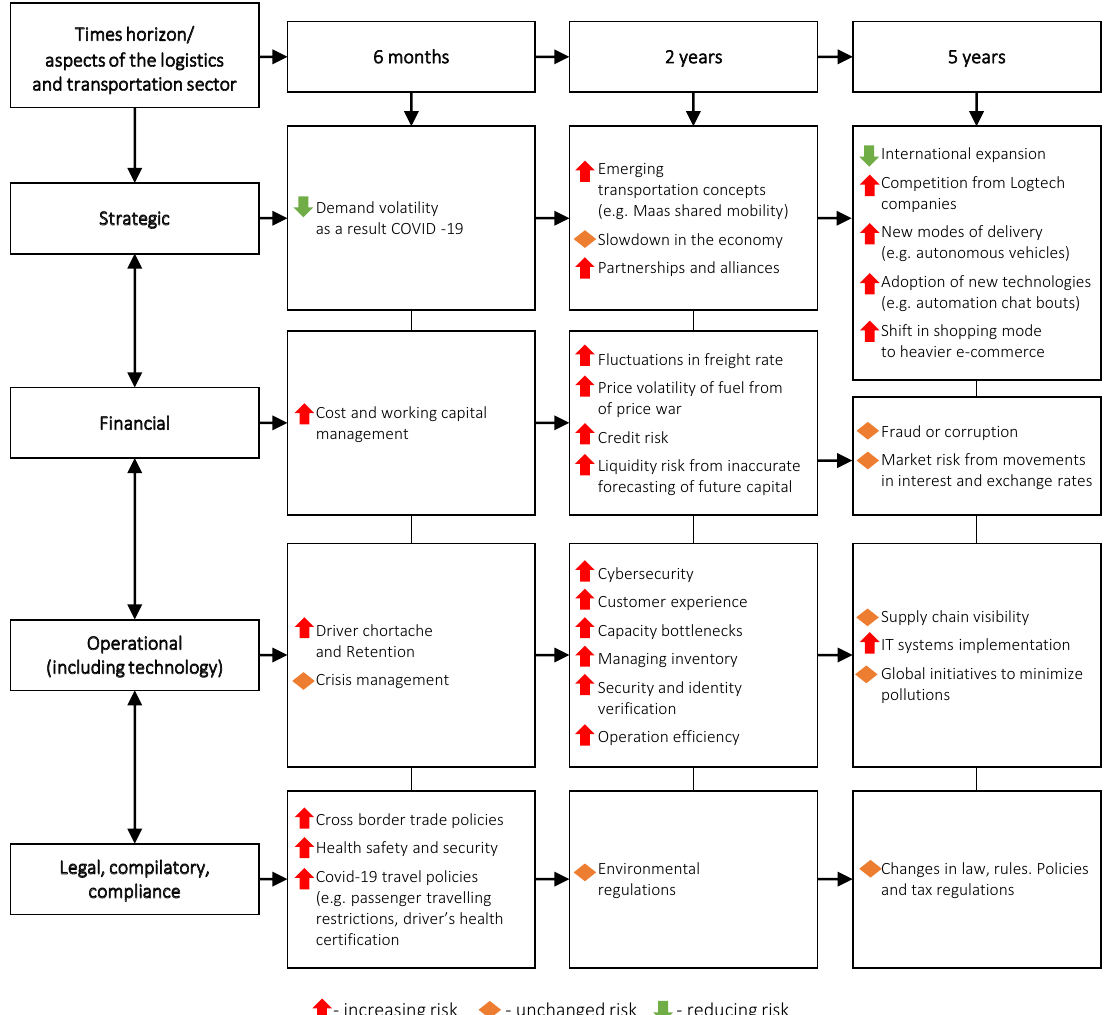
Figure 4. Predictive analysis (6 months to 5 years period) of the COVID-19 impact on major aspects of the logistics and transportation